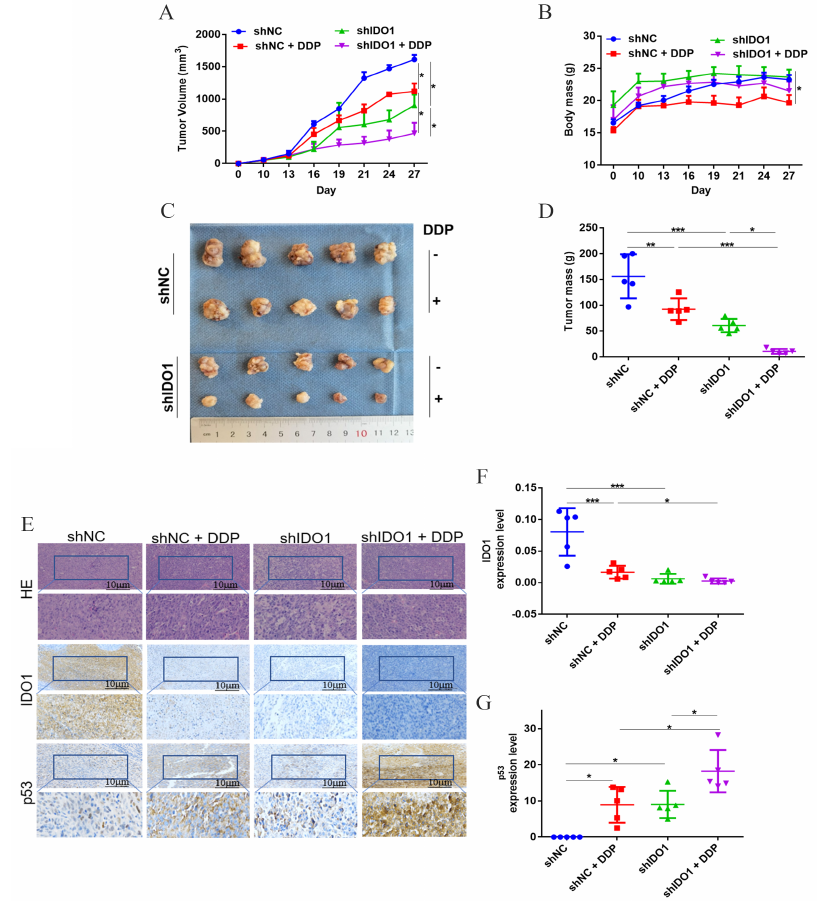
Figure 4. Silencing IDO1 enhanced action of DDP in vivo. ( A ) The tumor volume vs. day curve. ( B ) Alteration in the body mass of mice. ( C , D ) Macroscopic tumors and tumor mass after treatments. ( E – G ) Expression of IDO1 and p53 in tumor tissues; the scale bar was 10 µ m. Data were mean ± standard deviation for 5 mice. *: p < 0.05; **: p < 0.01; ***: p < 0.001.